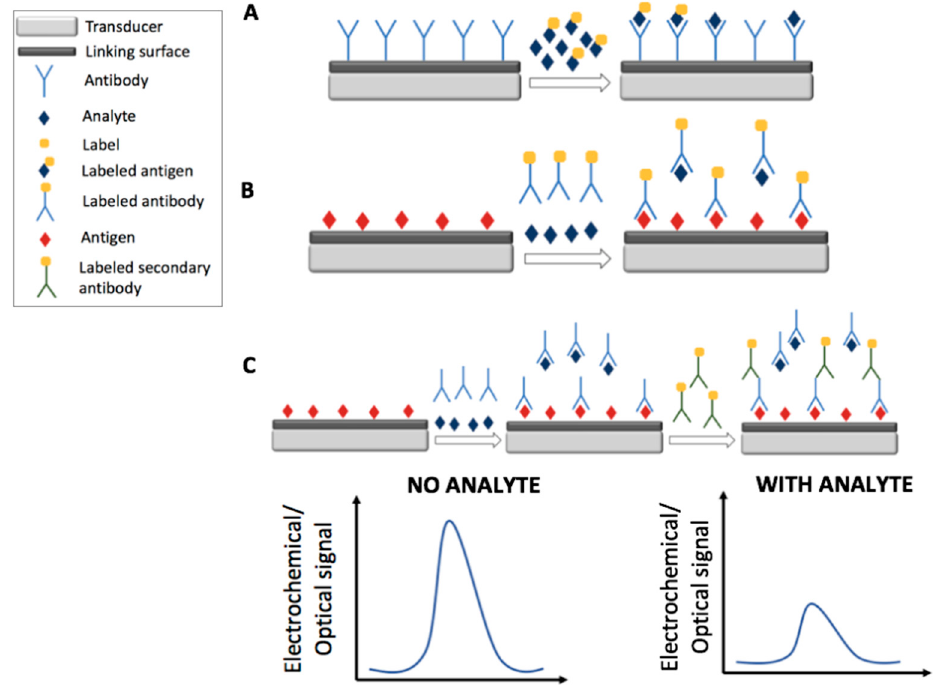
Figure 2. Schematic representation of electrochemical and optical labeled competitive detection strategies by the use of immunosensors: competition for the antibody among the analyte and the labeled antigen ( A ); competition for the labeled antibody among the analyte and the antigen ( B ); competition for the antibody among the analyte and the antigen and detection by the use of a labeled secondary antibody ( C ).